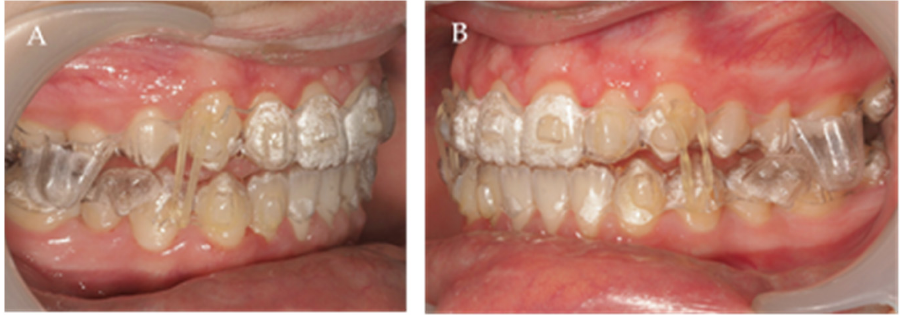
Figure 8. Second AA, with precision wings (blue color) on the last jump. Black dots—complex movements.